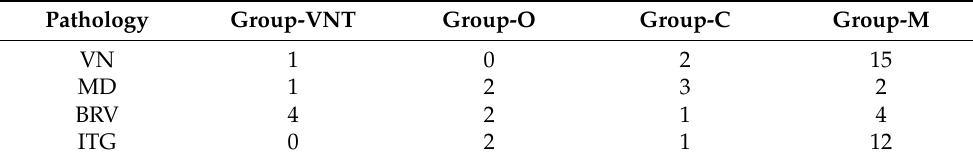
Table 1. Number of diagnoses by group.